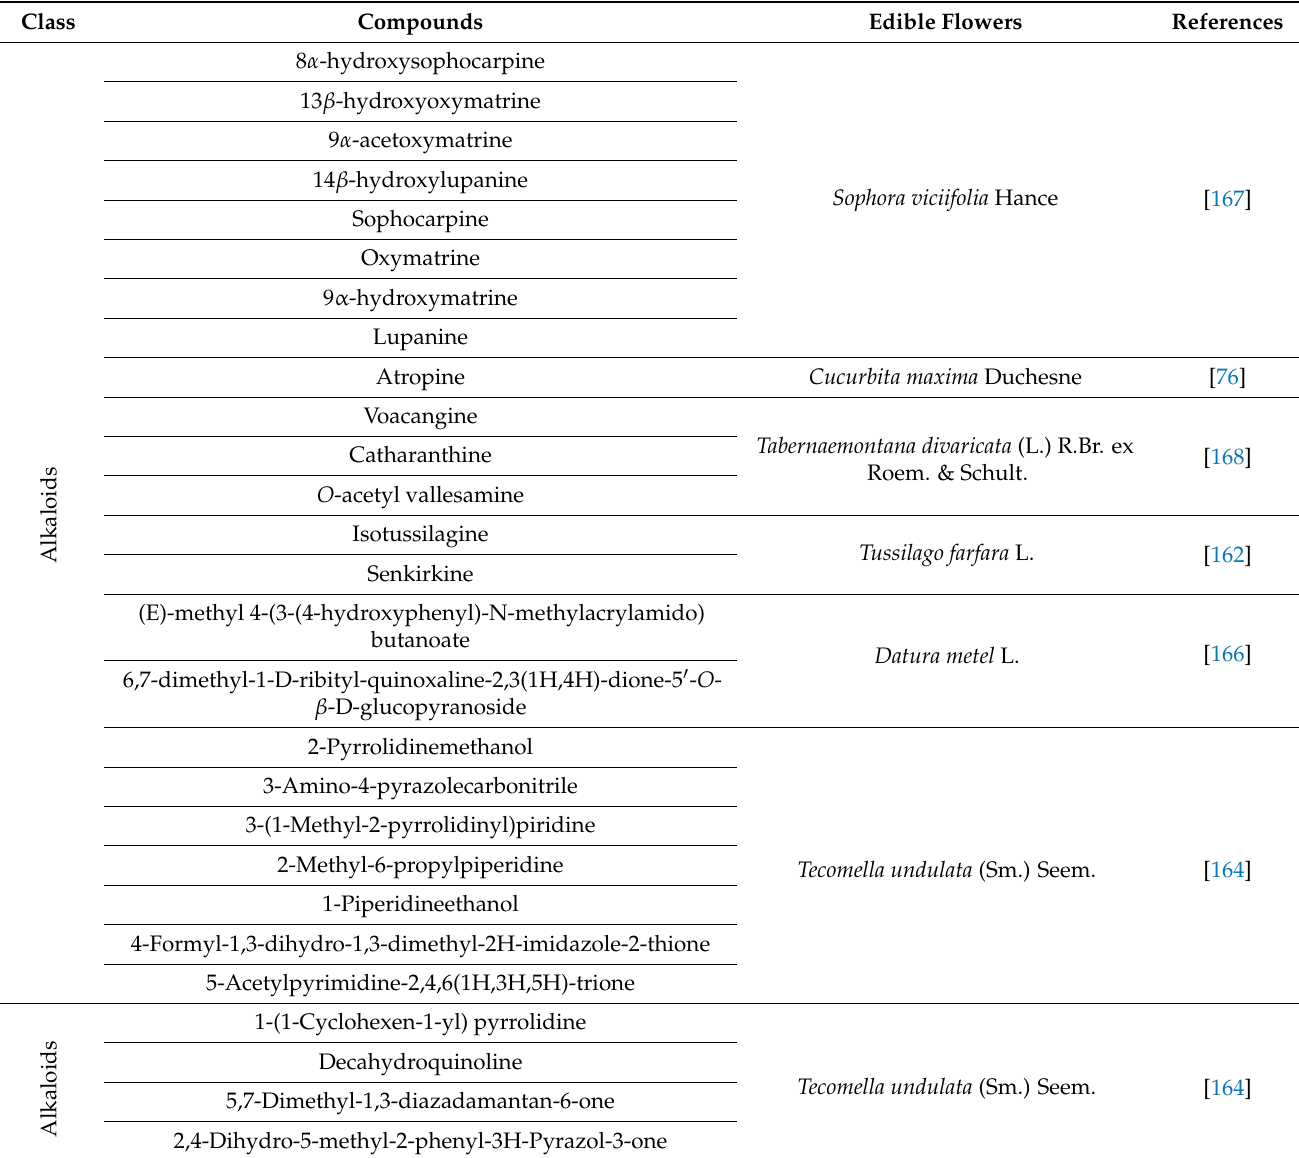
Table 4. Alkaloids and betacyanins found in edible